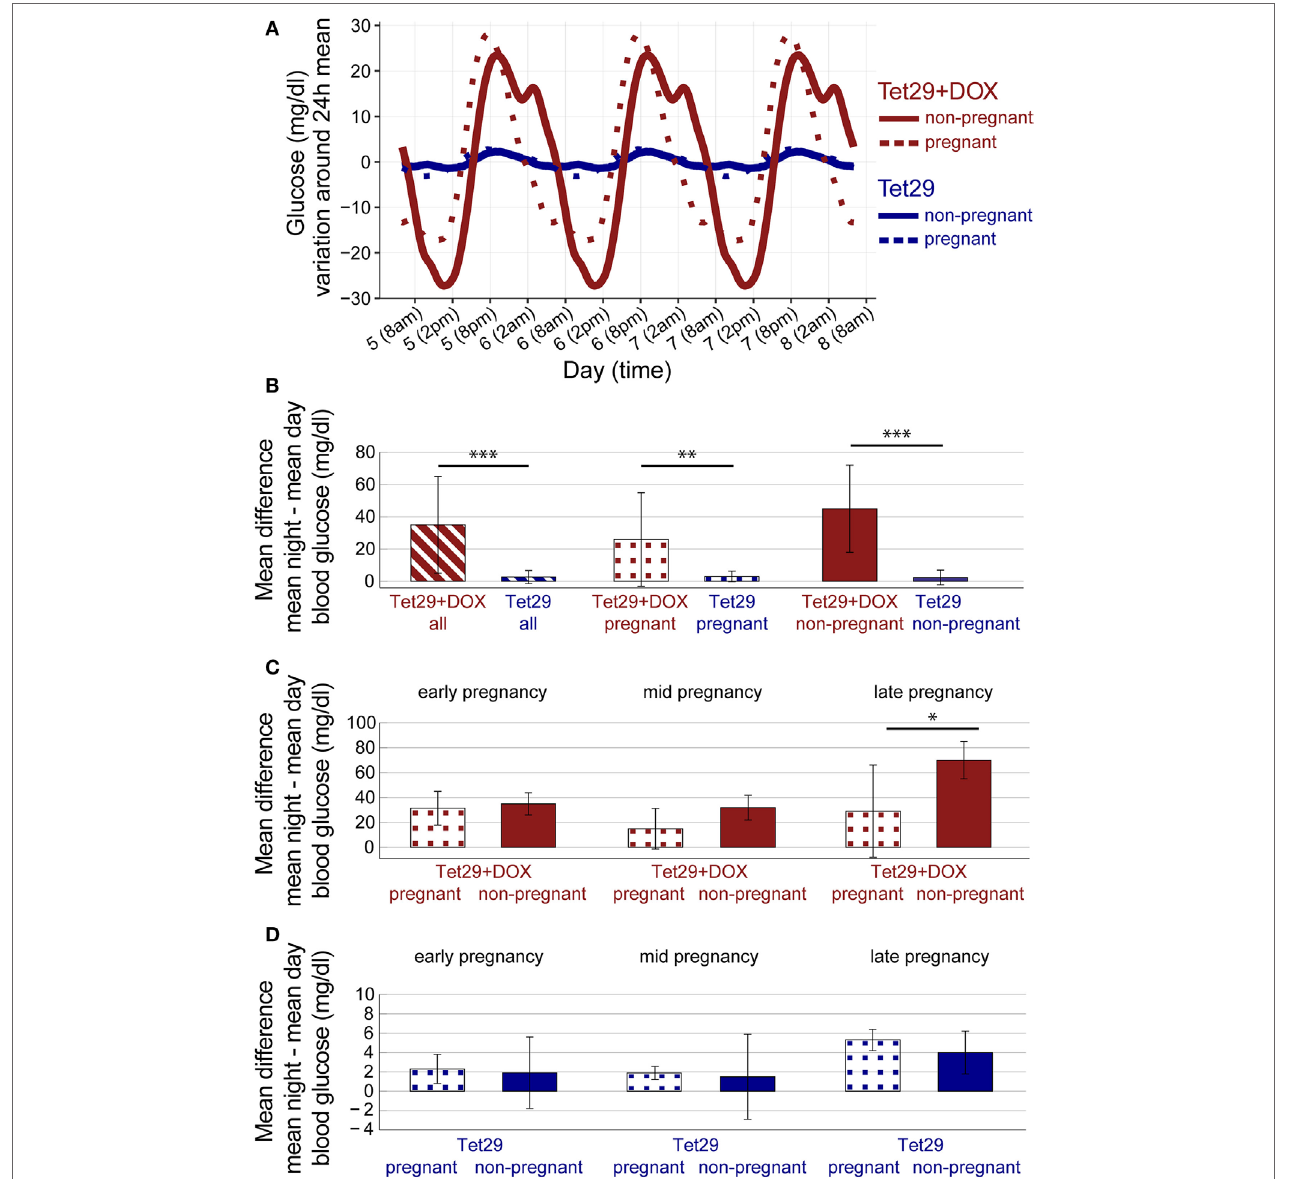
FigUre 2 | Circadian variation of blood glucose during pregnancy. (a) Diurnal variability of blood glucose per group between pregnancy day 5 and 7 or the corresponding period in non-pregnant rats. Data were first averaged over animals within groups for every minute, then smoothed by moving average. DOX = Doxycyclin; There is a circadian variation of blood glucose in all four groups with higher values at night. (B) Shown is the mean difference ± SD between mean night and mean day blood glucose during pregnancy or the corresponding period per group. Tet29 + DOX rats, both pregnant and non-pregnant, had a higher difference in night and day blood glucose values than Tet29 rats, both pregnant and non-pregnant (repeated measures ANOVA). In addition, pregnant Tet29 + DOX rats had a higher difference in night and day blood glucose values than pregnant Tet29 rats (repeated measures ANOVA), and non-pregnant Tet29 + DOX rats had a higher difference in night and day blood glucose values than non-pregnant Tet29 rats (repeated measures ANOVA). (c) Shown is the mean difference ± SD between mean night and mean day blood glucose during the different periods of pregnancy or the corresponding periods in non-pregnant rats within the Tet29 + DOX rats. Pregnancy decreased the difference between night and day blood glucose in diabetic Tet29 + DOX rats during late pregnancy ( post-hoc comparison). (D) Shown is the mean difference ± SD between mean night and mean day blood glucose during the different periods of pregnancy or the corresponding periods in non-pregnant rats within the Tet29 rats. Pregnancy had no effect on the difference between night and day blood glucose in normoglycemic Tet29 rats during any time period of pregnancy ( post-hoc comparison). (a–D) n = 3 non-pregnant Tet29, n = 3 pregnant Tet29, n = 5 non-pregnant Tet29 + DOX, n = 5 pregnant Tet29 + DOX.